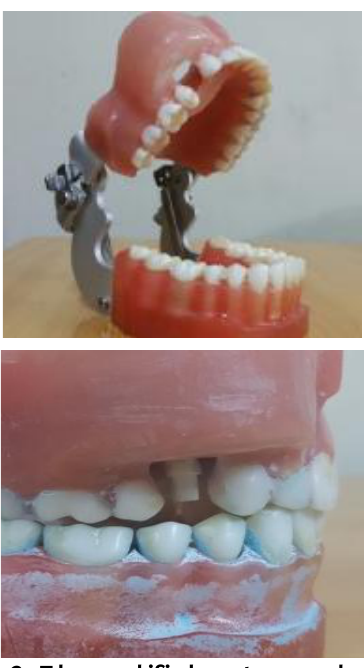
Figure 2: The modified custom made model The teeth samples in (group A) were scanned